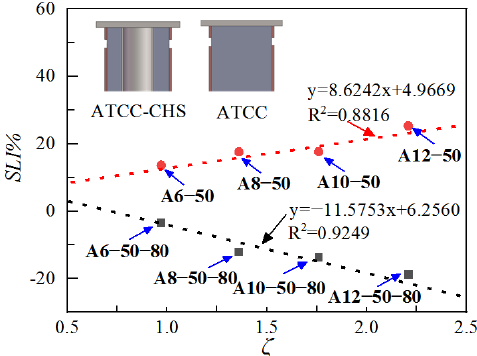
Figure 10. SLI– ζ relationships. Figure 10. SLI –ζ relationships.